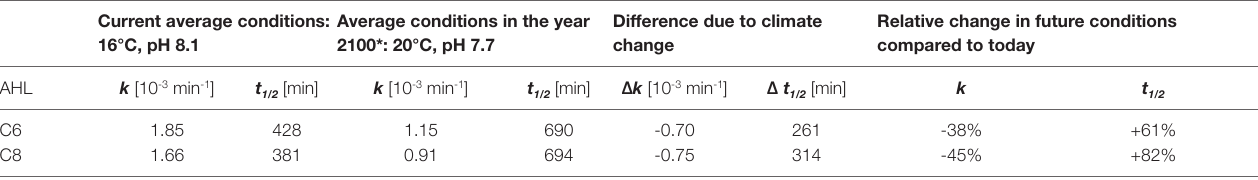
TABLE 4 | Hydrolysis rate and half-life time of C6- and C8-HSL in average current and future conditions. Current average conditions: 16°C, pH